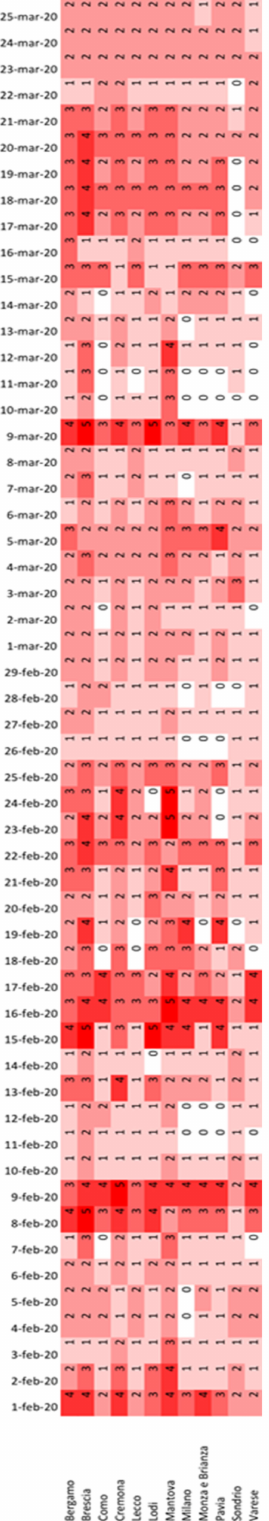
Figure 9. Co-occurrence of PM10, PM2.5, relative humidity, ambience temperature, and net atmo- spheric